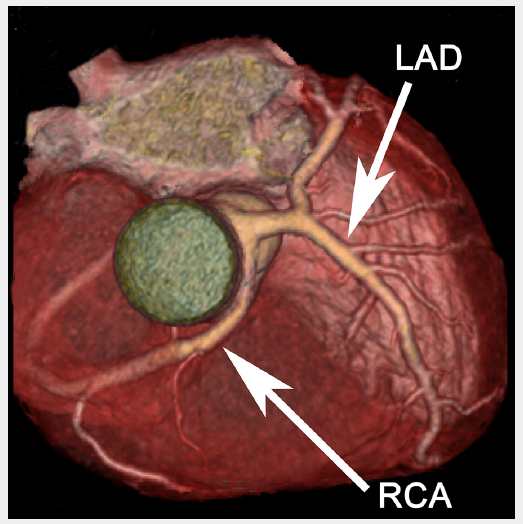
Incidental finding of an ACAOS variant with RCA originating from LCS and a malignant interarterial course of the vessel in a patient referred for CCTA for exclusion of CAD. ACAOS = anomalous coronary arteries originating from the opposite sinus Valsalva; CAD = coronary artery disease; CCTA = coronary computed tomography angiography; LAD = left anterior descending artery; LCS = left coronary sinus; RCA = right coronary artery